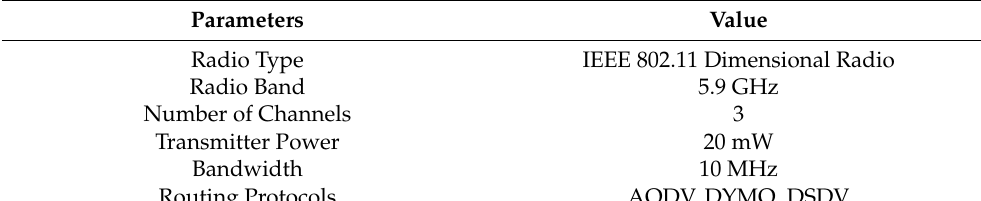
Table 2. Simulation Parameters—OMNeT++.